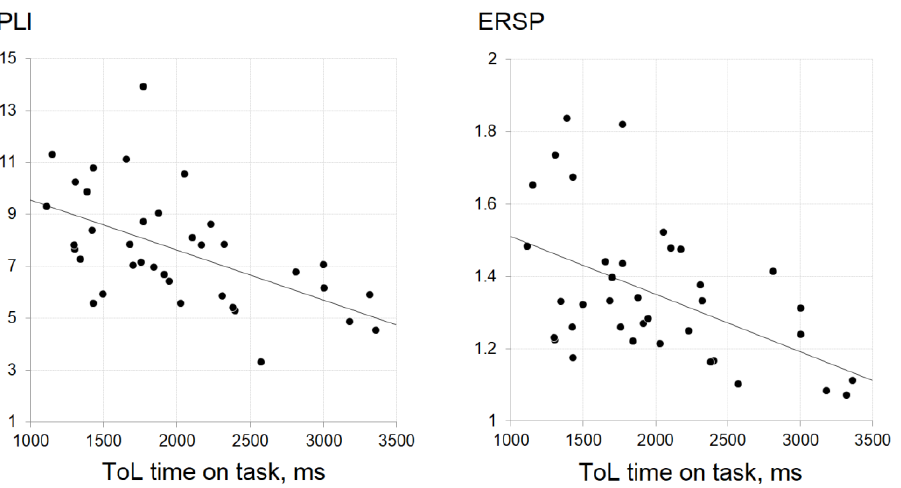
Figure 4. Scatterplots of PLIs and ERSPs at IGFs against the Tower of London task response times.